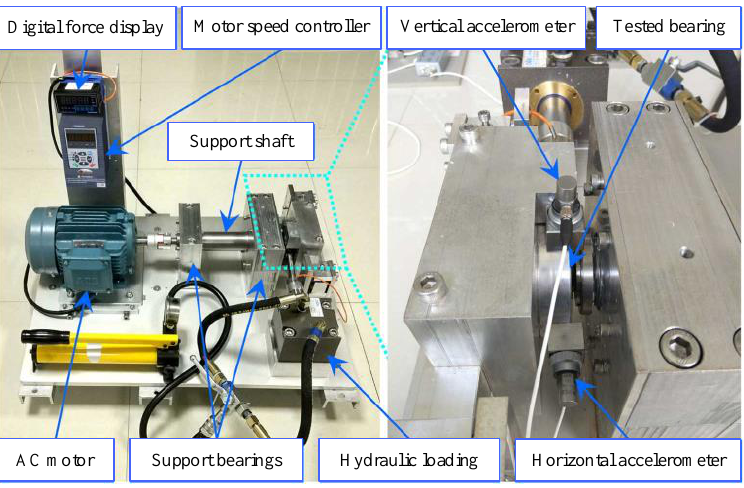
Figure 14. The layout of the bearing accelerated degradation test rig of Case 2.